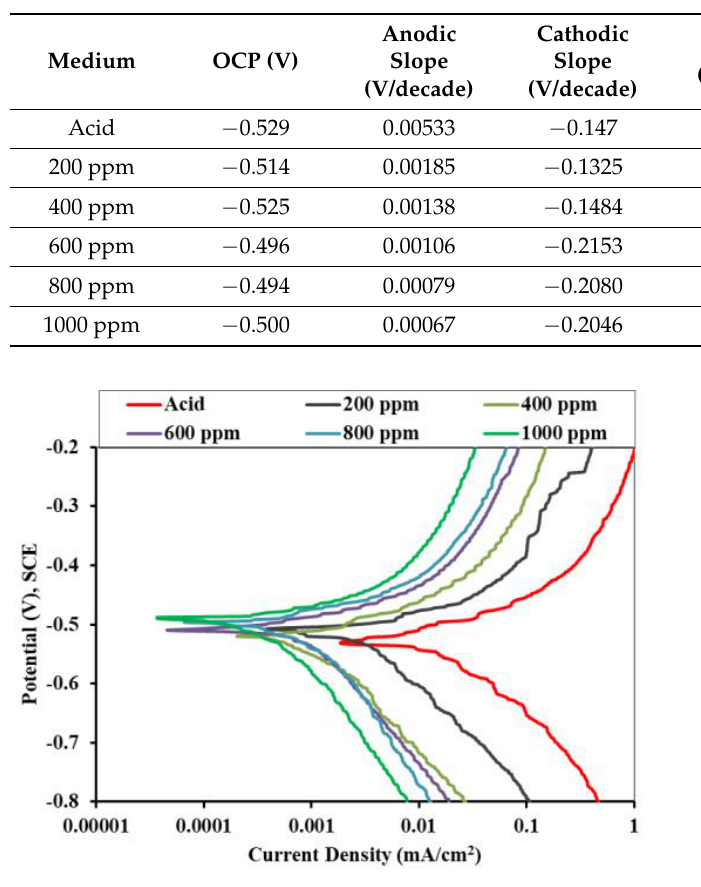
concentrations of inhibitor immersed condition. Figure 8. Potentiodynamic polarization curves for mild steel in 1 M H 2 SO 4 containing different